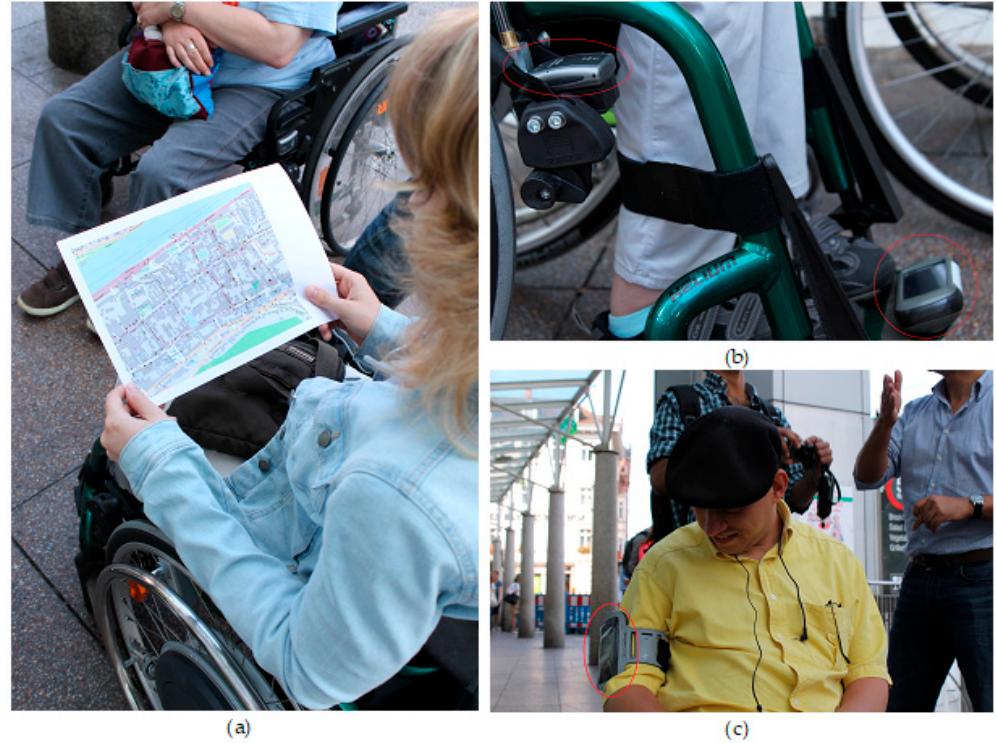
Figure 4. The navigation experiment: ( a ) a wheelchair user checking the navigation plan; ( b ) two GPS devices installed on wheelchair; and ( c ) GPS device worn by a user.